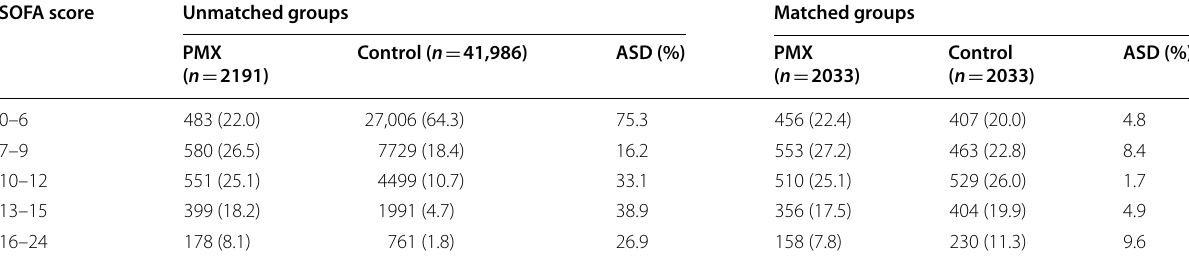
Table 3 The number of patients in each SOFA score category before and after propensity score matching SOFA score